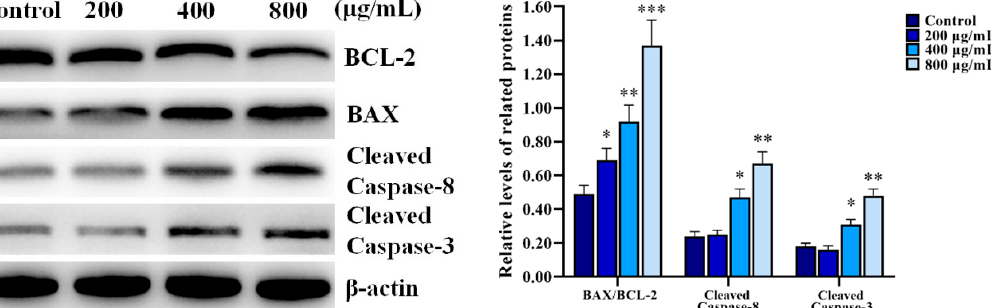
Figure 5. Effect of SNPs on the activation of autophagy and the apoptotic pathway. ( A ) Autophagy was determined by MDC staining. Scale bar, 50 µm ( Aa – Ad ) and 10 µm ( Ae – Ah ). ( B ) Autophagy-related proteins were detected by Western blotting. ( C ) Bar graphs of the analyses of band intensity in ( B ) as the relative ratio of the proteins related to β -actin. ( D ) Apoptosis-related proteins were detected by Western blotting. The PLCs were treated with control, 200, 400, and 800 µg/mL SNPs for 12 h. ( E ) Bar graphs of the statistical analyses of band intensity in ( D ) as the relative ratio of the proteins related to β -actin. Note: * p < 0.05, ** p < 0.01, and *** p < 0.001 compared to the control.